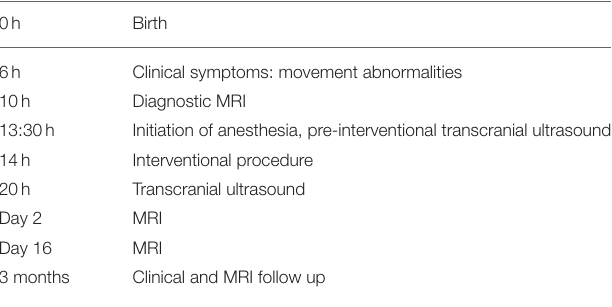
TABLE 1 | Timeline of clinical and procedural data.